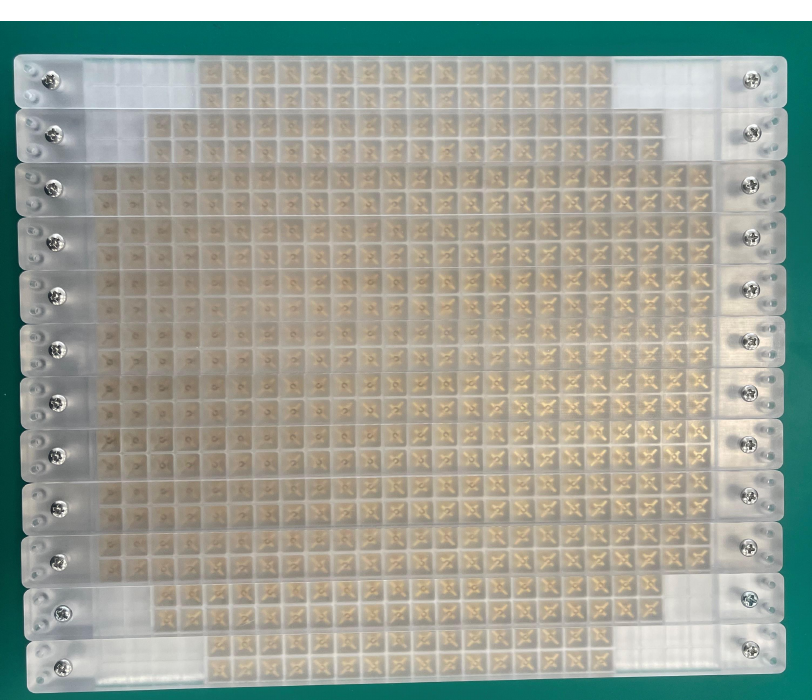
Figure 7. Planar phased array